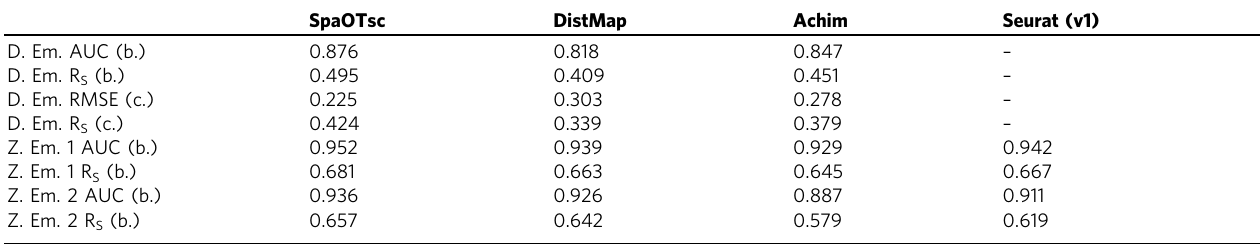
Three other recognized methods are evaluated which are DistMap (ref. 10 ), Achim (ref. 12 ), and Seurat v1 (ref. 13 ). Both zebra fi sh examples use the spatial data from ref. 13 . The two zebra fi sh examples use scRNA-seq data from ref. 13 (Z. Em. 1) and ref. 36 (Z. Em. 2), respectively. The Drosophila example (D. Em.) uses data both from ref. 10 . The application of Seurat (v1) to the Drosophila dataset